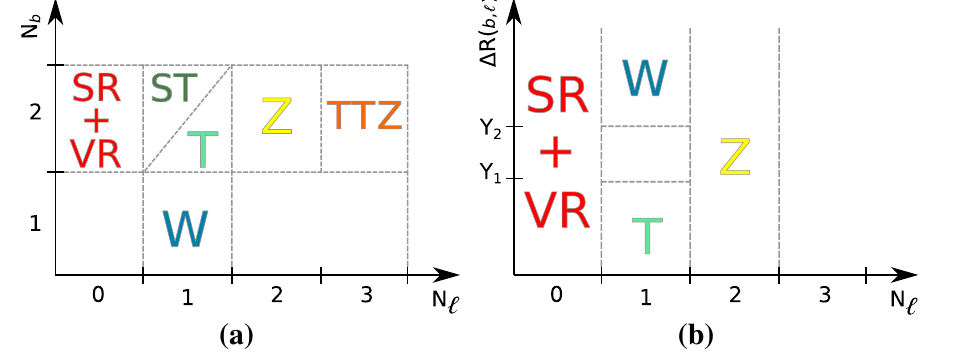
Fig. 3 A summary of the background control region strategy used in the a SRA–Band b SRDfits.Theorthogonalitybetweenthe Z + jets(Z), t ¯ t + Z (TTZ), t ¯ t (T), W + jets (W), and single-top (ST)